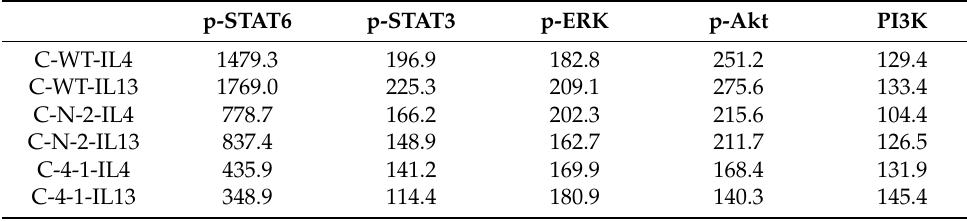
Table 2. Pathway activation after exogenous cytokine stimulation. Protein phosphorylation was determined with ImageJ 1.52a and grey-scale values were corrected by loading